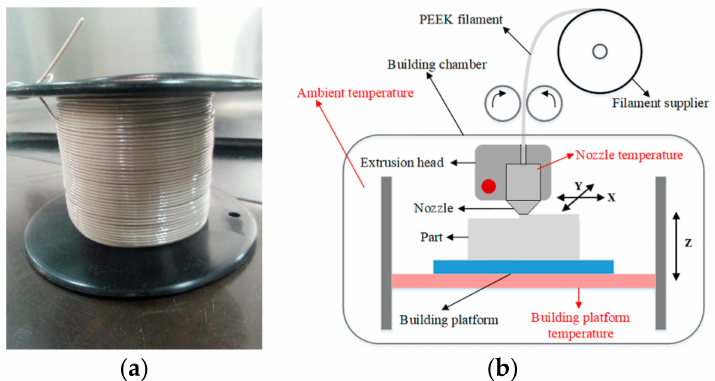
Figure 1. The filament and fused deposition modeling (FDM) printer: ( a ) Poly-ether-ether-ketone (PEEK) filament extruded in the lab. ( b ) The homemade FDM printer for PEEK: the temperature of the